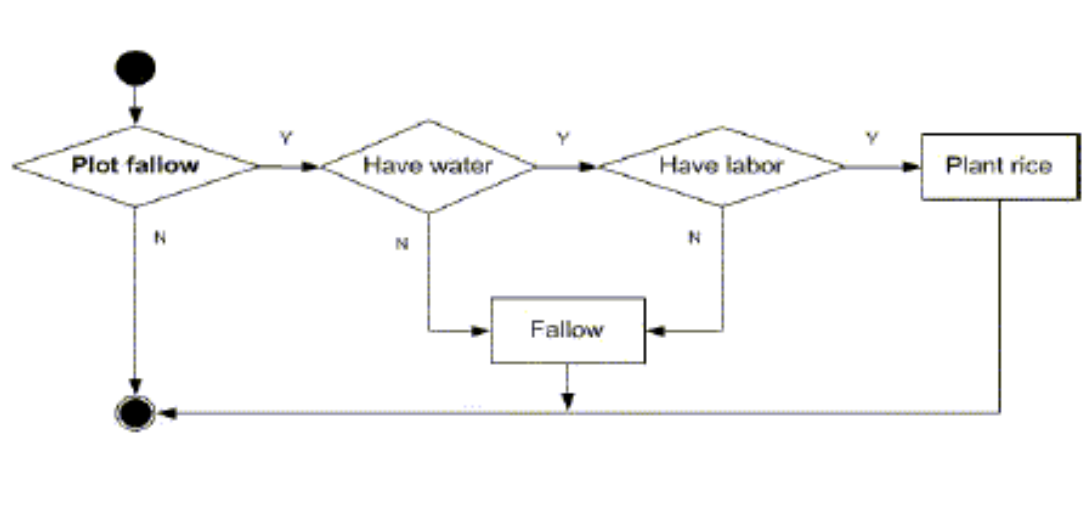
Fig. A2.4. The “PlantRice” task in the Limbukha